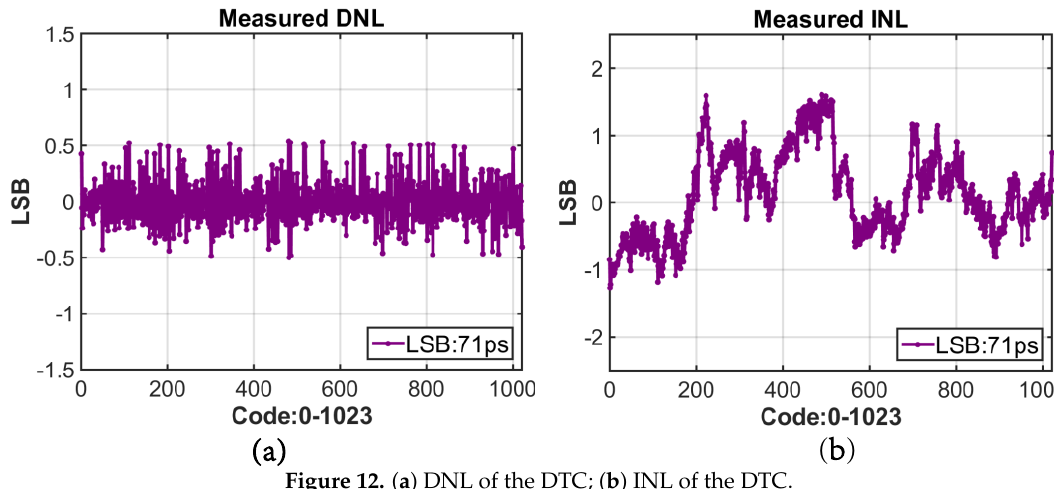
Figure 12. ( a ) DNL of the DTC; ( b ) INL of the DTC.